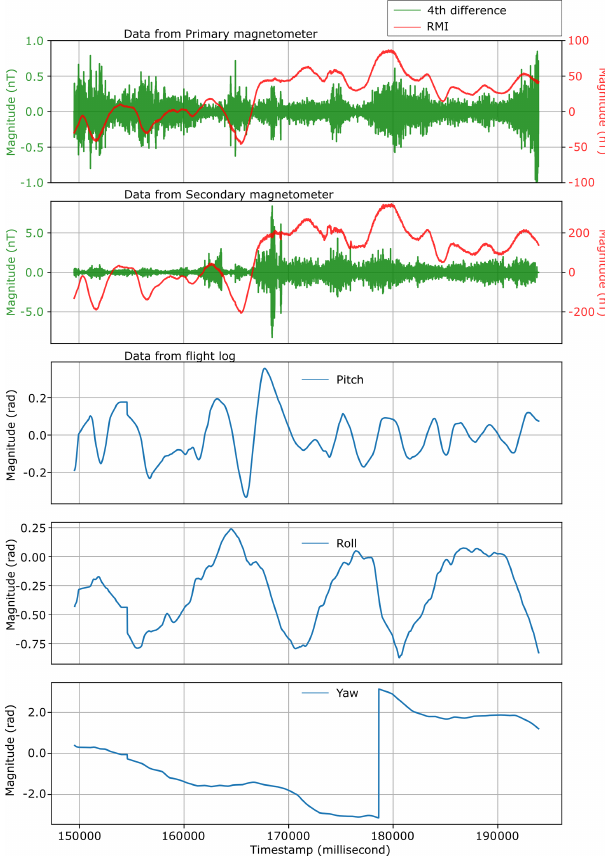
Figure 15. The RMI of the second segment from left to right in Figs. 12 and 13 and the corresponding attitude from the flight